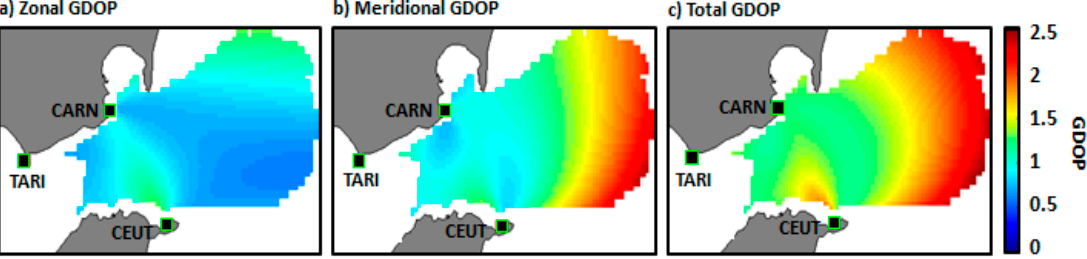
Figure 2. Geometric Dilution of Precision (GDOP) for the geometry of Gibraltar HFR system: ( a ) Zonal GDOP; ( b ) Meridional GDOP; ( c ) Total GDOP.